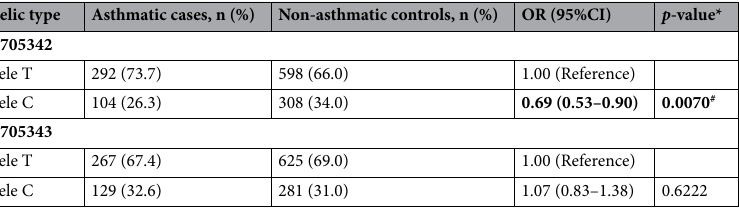
Table 4. Distribution of miR-145 allelic frequencies among asthmatic patients and non-asthmatic controls. OR odds ratio, CI confidence interval. *Based on Chi-square test without Yates’ correction. # Statistically significant.